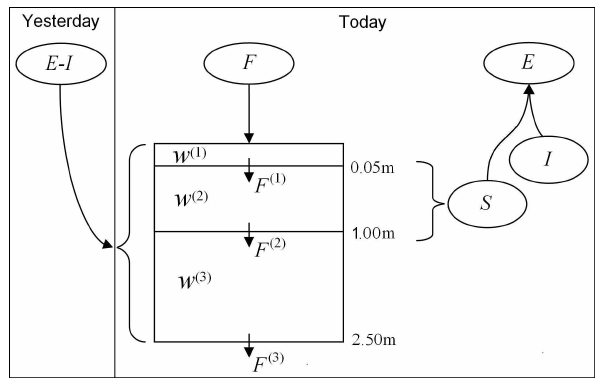
Fig. 2. Schematic overview of the running water balance for the fraction of tall canopy (three layer profile). In this example, the second layer is the wettest layer and therefore it determines the stress factor, S (see Sect. 2.3).